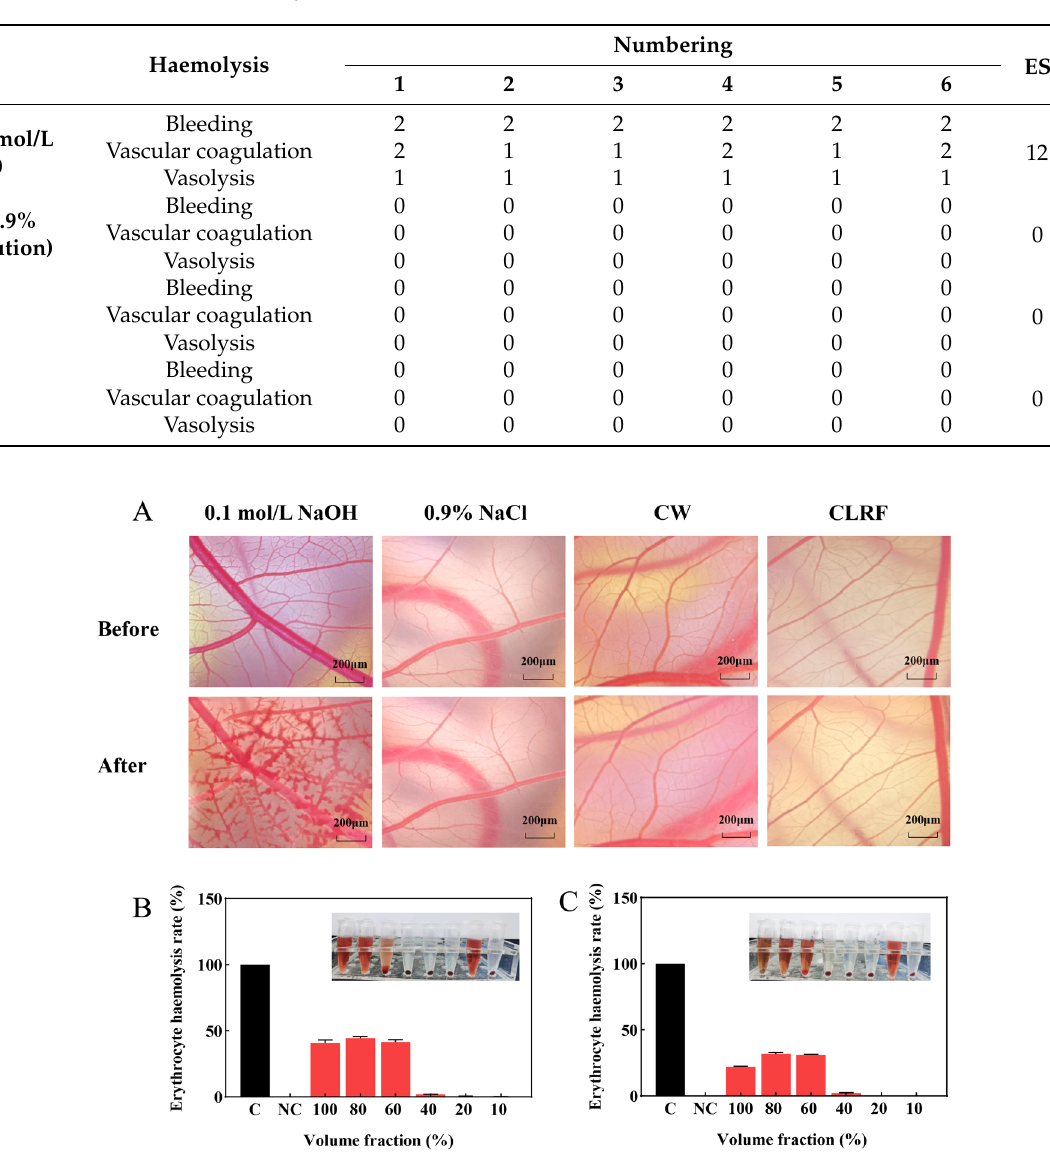
Table 4. Results of Eye Irritation of Chicken Chorioallantoic Membrane.